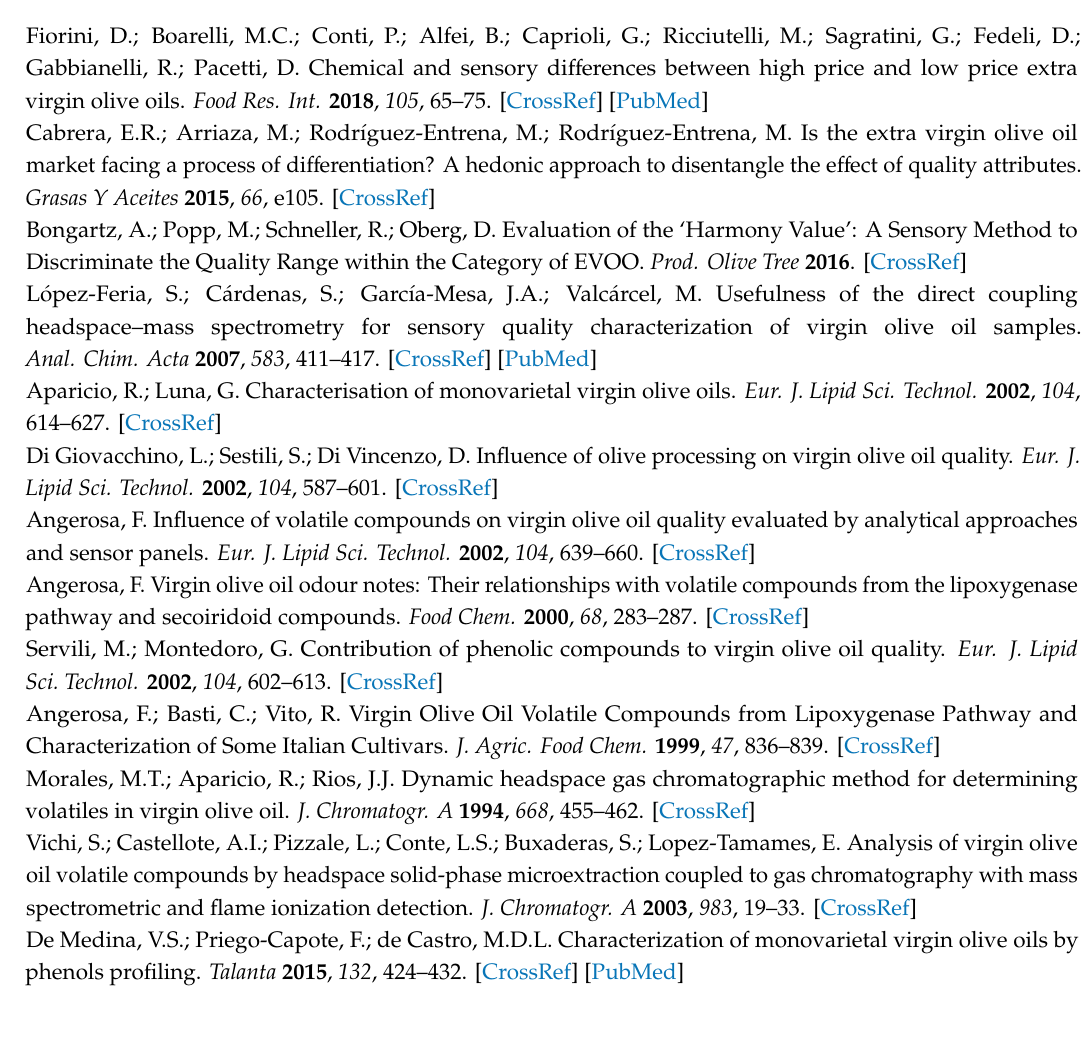
Supplementary Materials: The following are available online, Figure S1: Chromatograms of volatile aroma compounds found in monovarietal PDO and commercial-blended extra virgin olive oil by headspace solid-phase microextraction combined with gas chromatography / mass spectrometry (HS-SPME-GC-MS). Figure S2: Contour plots (2D-chromatograms) of volatile aroma compounds found in a) monovarietal PDO and commercial-blended extra virgin olive oils by headspace solid-phase microextraction combined with comprehensive two-dimensional gas chromatography-mass spectrometry (HS-SPME-GC × GC-TOF-MS). Figure S3: Chromatograms of phenols found in a) monovarietal PDO and b) commercial-blended extra virgin olive oils by high-performance liquid chromatography with UV at wavelength of 280 nm and 310 nm respectively. Figure S4: Principal component analysis (PCA) of HPLC-DAD-MS data; (a) indicates the score plot with all compounds; (b) loading plot correlated with sensory attributes in EVOO samples. Table S1: Standards used for all the analysis Author Contributions: Conceptualization, F.M., I.L. and U.V.; Data curation, N.M.; Formal analysis, A.D.R., D.M., S.R. and K.B.B.; Methodology, F.M. and U.V.; Writing – original draft, A.D.R.; Writing – review & editing, I.L. All the authors read and approved the